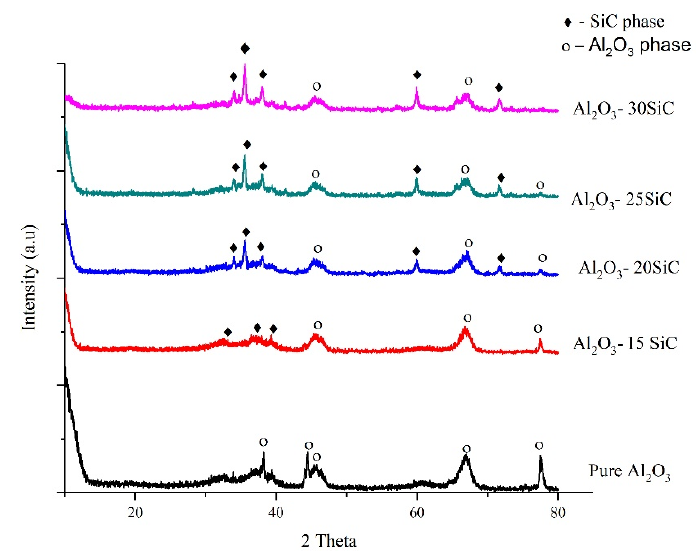
Figure 3. X-ray diffraction diffractograms for the produced powder composites. Table 2. Crystallite size as calculated by Williamson–Hall (W-H) approach.